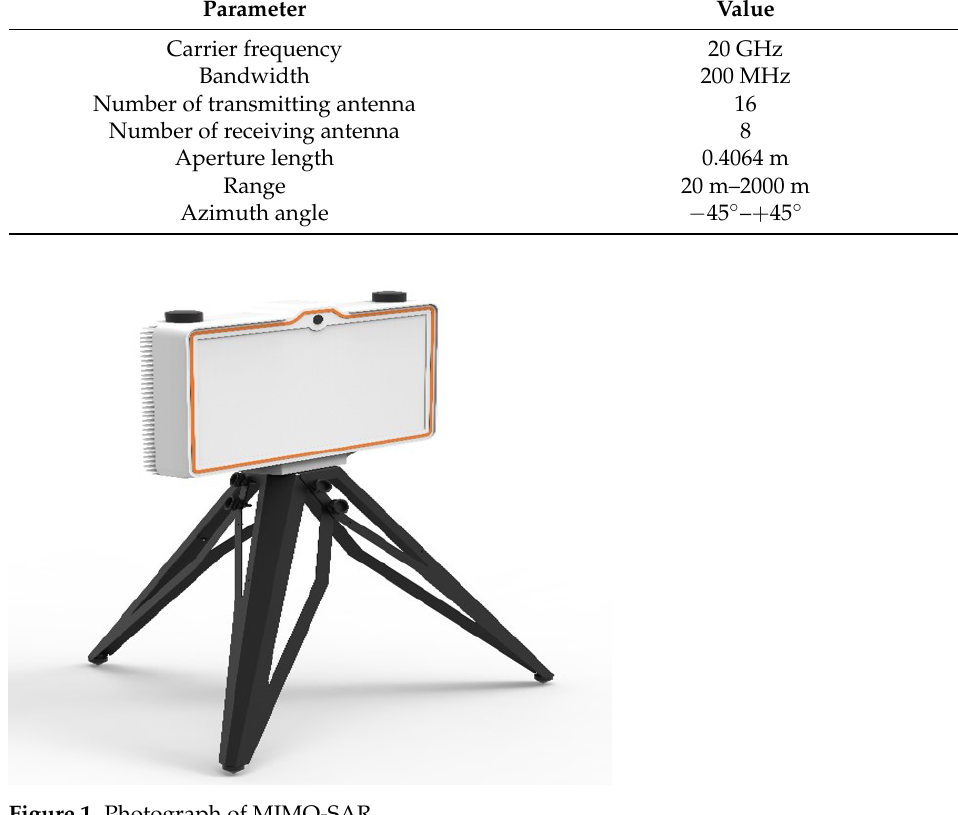
Figure 1. Photograph of MIMO-SAR.